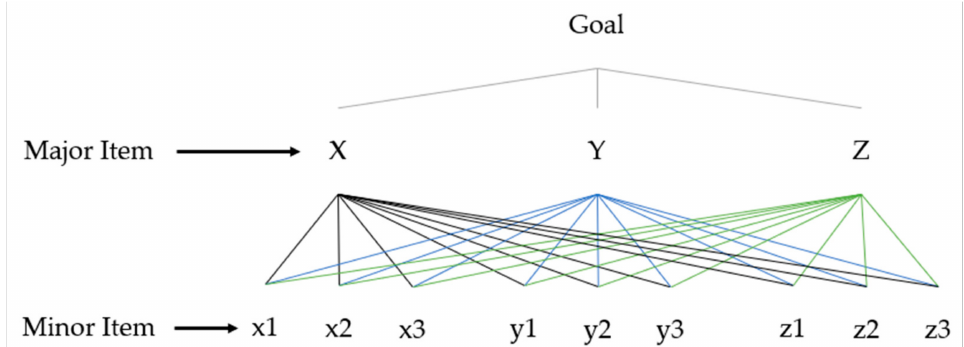
Figure 3. Pairwise comparison schematic